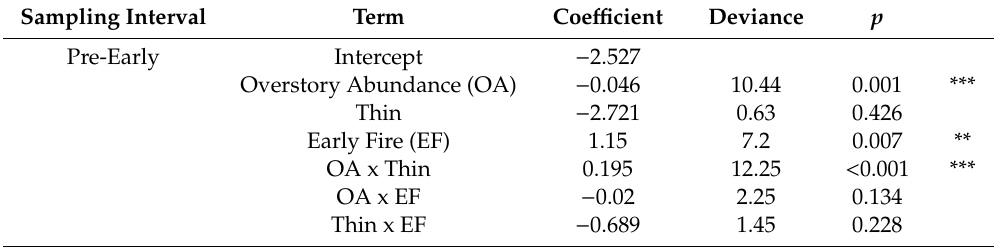
Table A5. Model results for colonization, an aspect of seedling dynamics, during each sampling interval ( n = 72 plots). Each response was analyzed with a GLM with a negative binomial distribution. Total deviance was 115.4, 132.8, and 139.2, for the Pre-Early, Early-Late, and Pre-Late intervals, respectively. Coe ffi cients are not back-transformed to original units. Statistical significance was evaluated using a chi-square test of the deviance explained by the term ( df = 1 for all terms). Results are not shown for persistence (another aspect of seedling dynamics) as those models did not